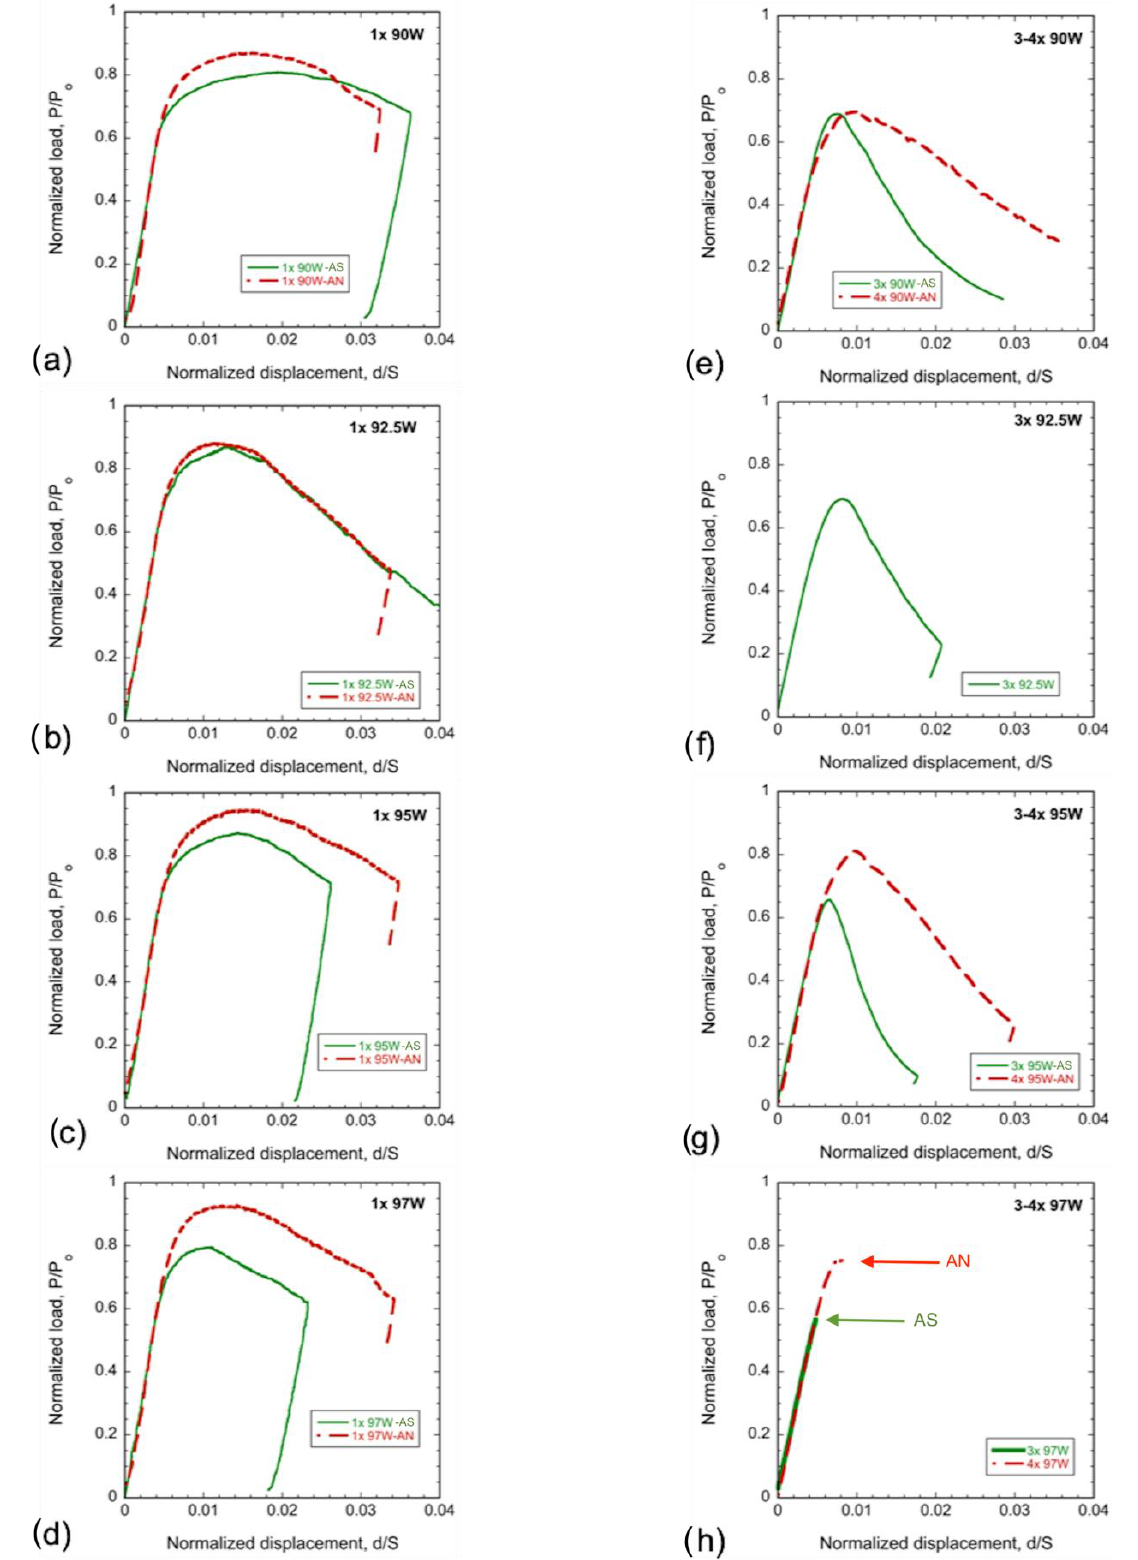
Figure 4. Representative RT normalized load-displacement (P/P o -d/S) curves for ( a – d ) 1 × and ( e – h ) 3 × AS and 4 × AN WHAs. Note, the 4 × 92.5W was not annealed. Here, solid green and broken red lines represent the AS and AN conditions,